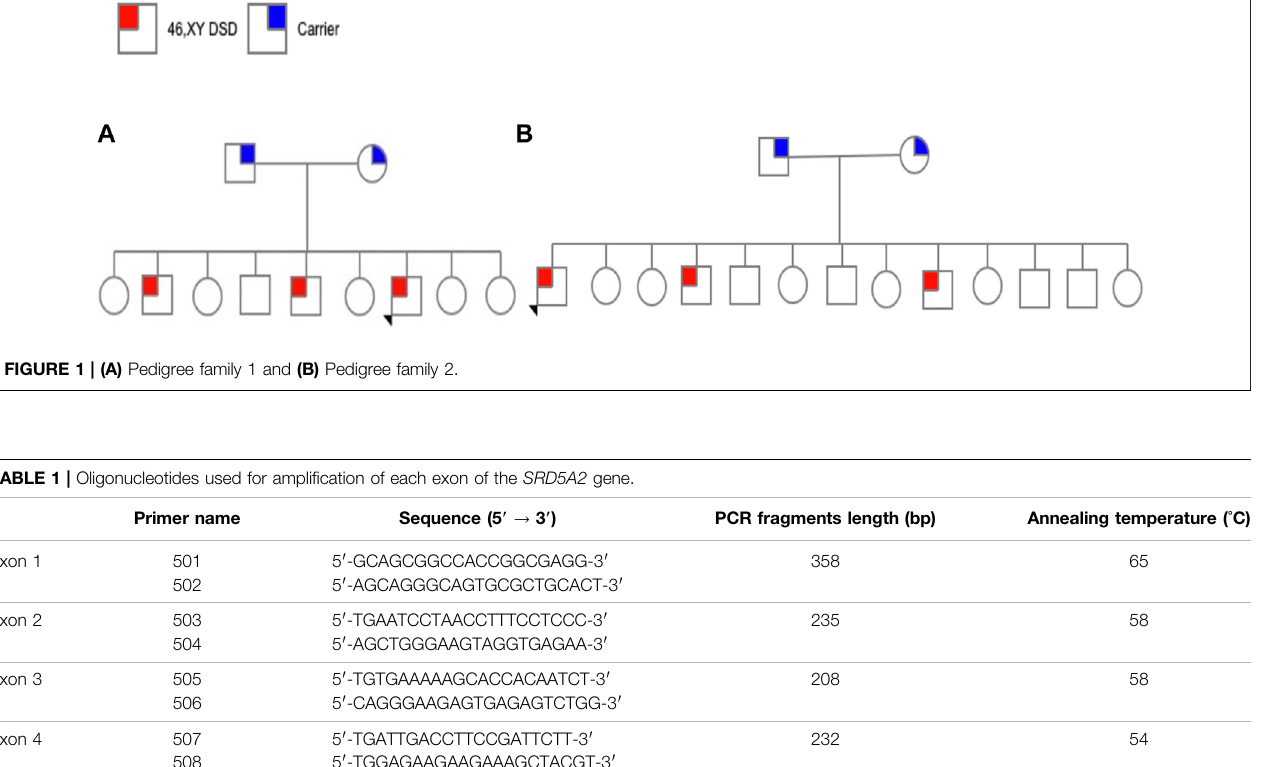
( Table 1 ); the design primers are from Labrie et al. (1992). The cycling conditions were as follows: 5 min denaturation at 95 ° C, then 25 cycles of 94 ° C for 1 min, 54 ° C – 65 ° C for 1 min, and 72 ° C